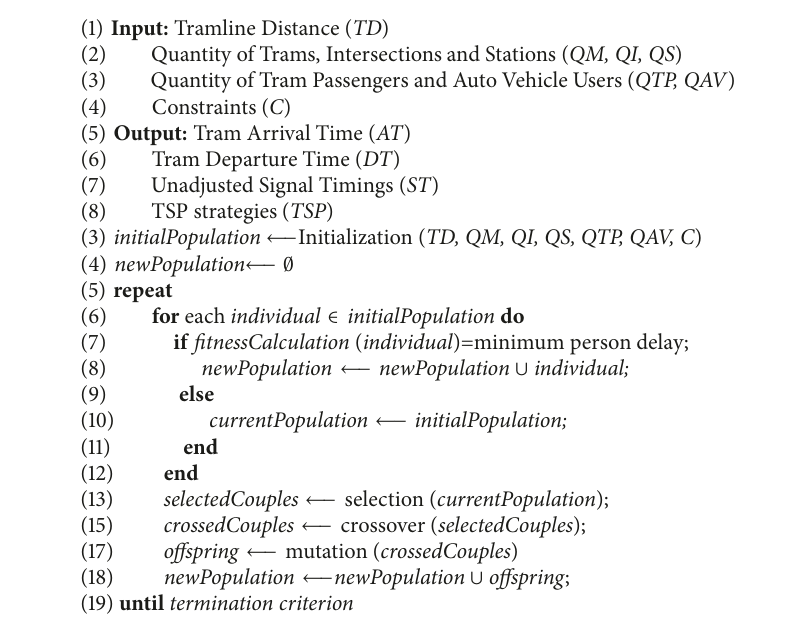
Algorithm 1: A Genetic Algorithm to solve the proposed model.